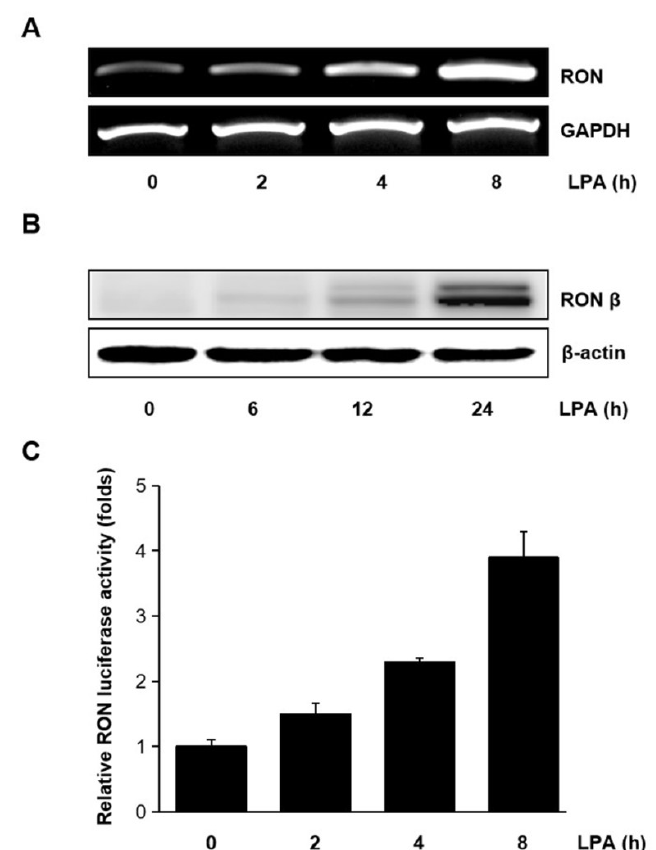
Figure 2. Induction of RON by lysophosphatidic acid (LPA) in T24 bladder cancer cells. ( A , B ) RT-PCR and Western blot analyses of the e ff ect of LPA on RON mRNA and protein expression in T24 cells, respectively. Cells were incubated with 5 µ M LPA for the indicated durations. ( C ) T24 cells were transiently transfected with the pGL3–RON reporter construct overnight. The transfected cells were incubated with 5 µ M LPA for 0–8 h, and luciferase activity was measured with a luminometer. Bars show the mean standard deviation from three measurements.